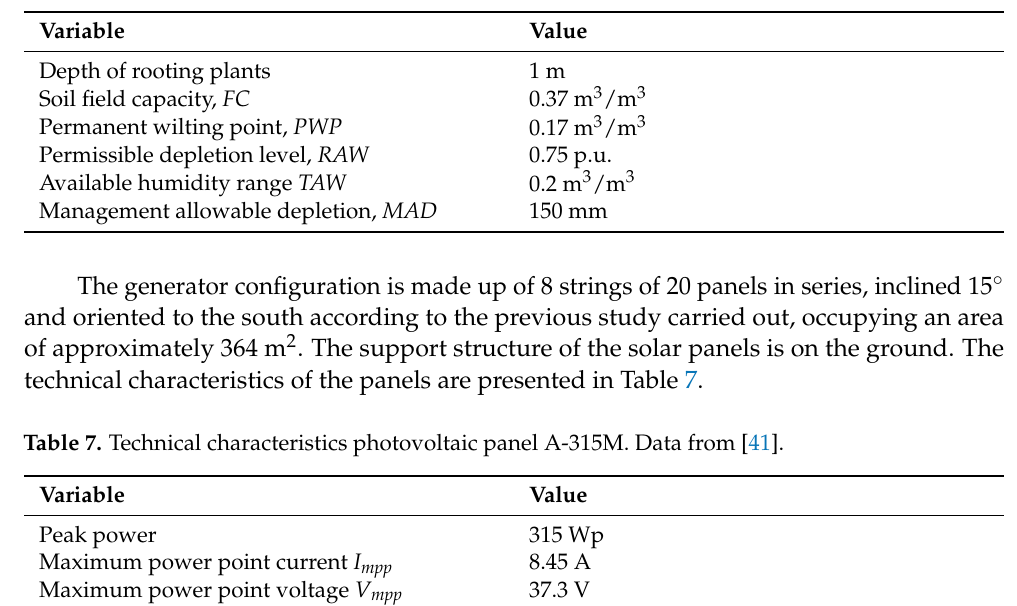
Table 6. Characteristics of the soil of the farm under study.